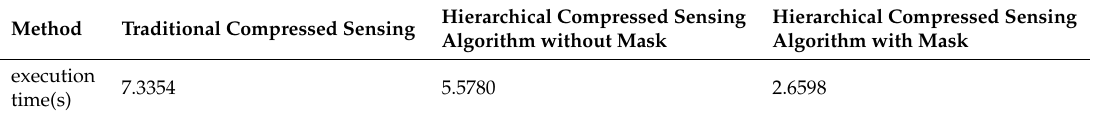
Table 1. Execution time of different methods.